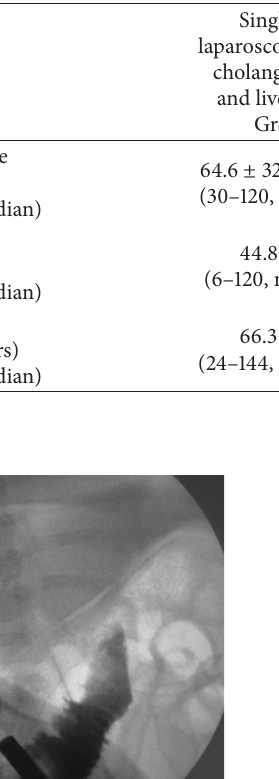
Table 1: Comparison of the groups who were detected to have patent ducts via either laparoscopy (Group I) or laparotomy (Group II). Tru-cut biopsy gave satisfactory information in all patients in Group I. In both groups, no complications were observed either in peroperative or in postoperative time.